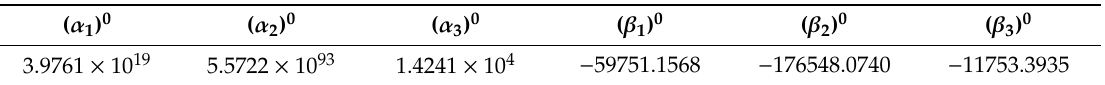
Table 3. Initial estimated values of parameters in the accelerated model for accelerometers.